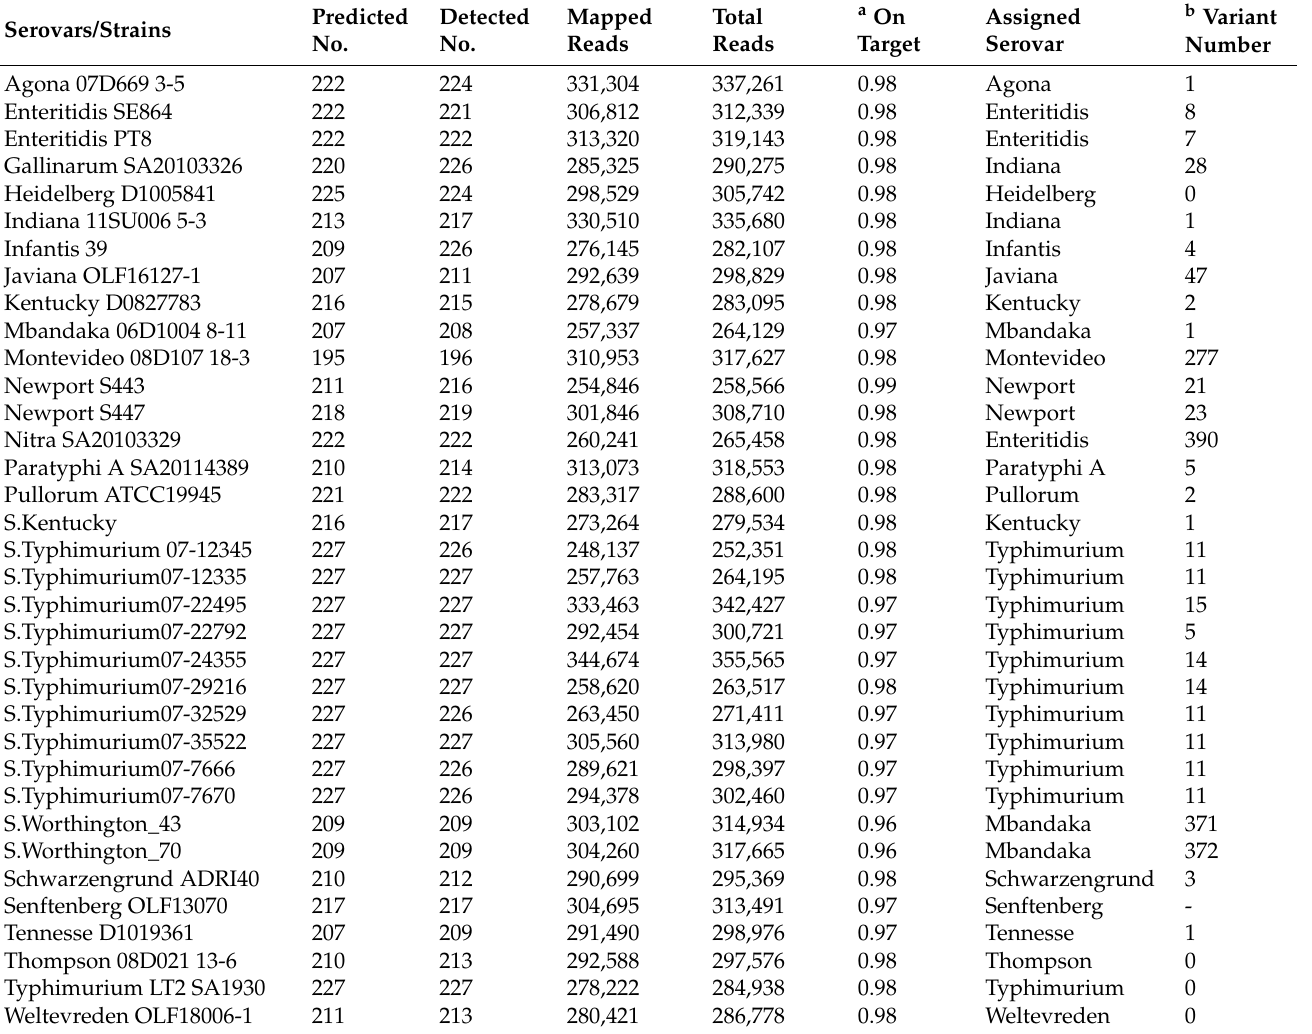
Table 2. Results of AmpliSeq analysis performed on strains of Salmonella with known serovar